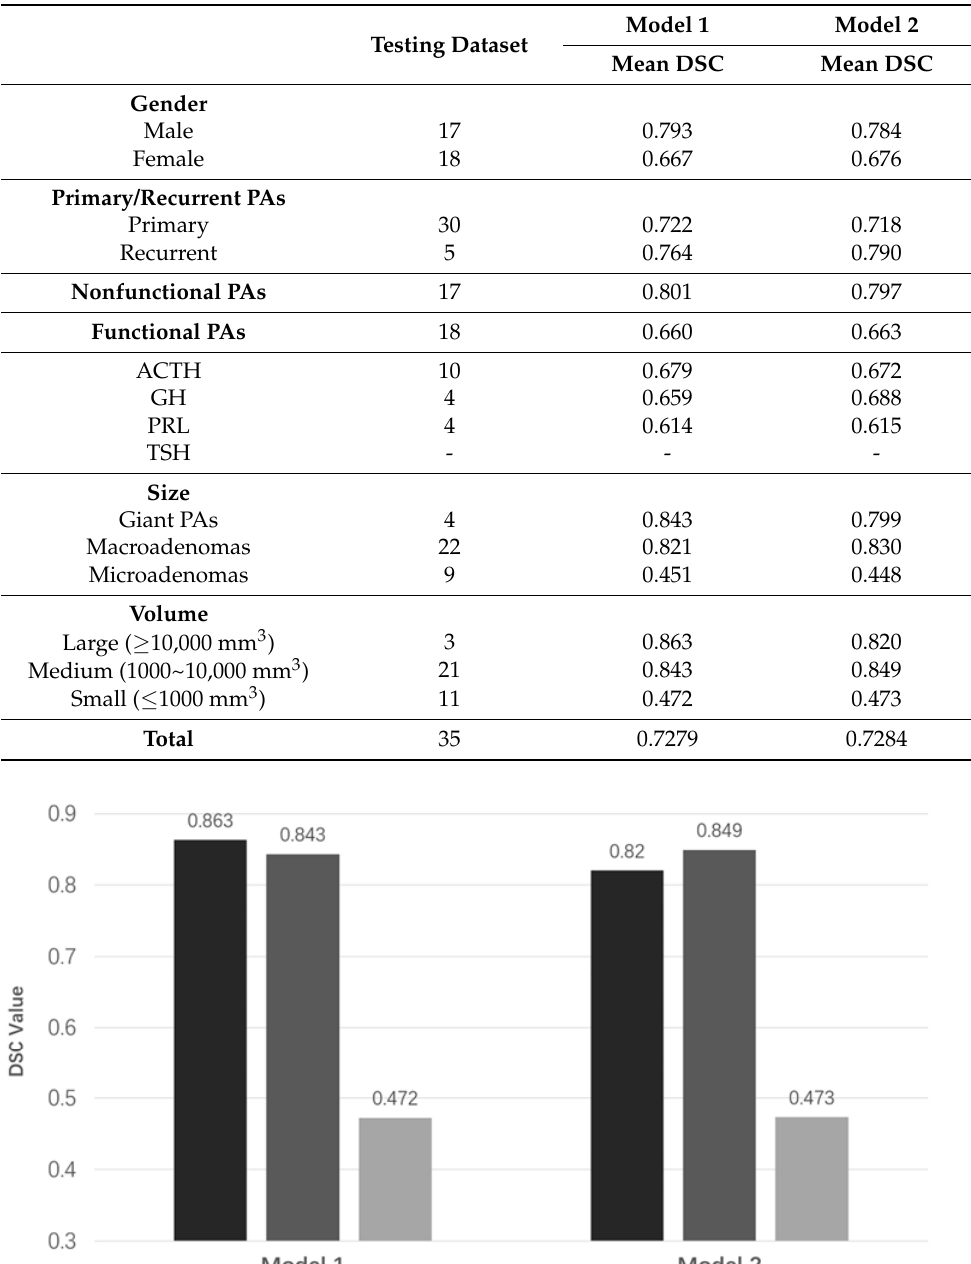
Table 3. Model performance of both models on the testing dataset.